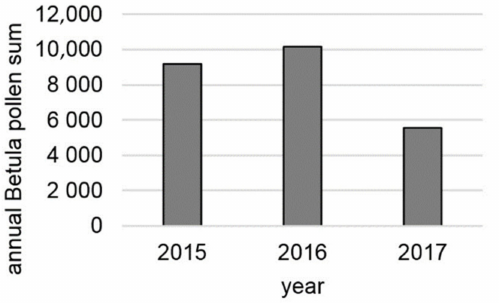
Figure 3. The annual pollen integrals of Betula spp. in Augsburg, during